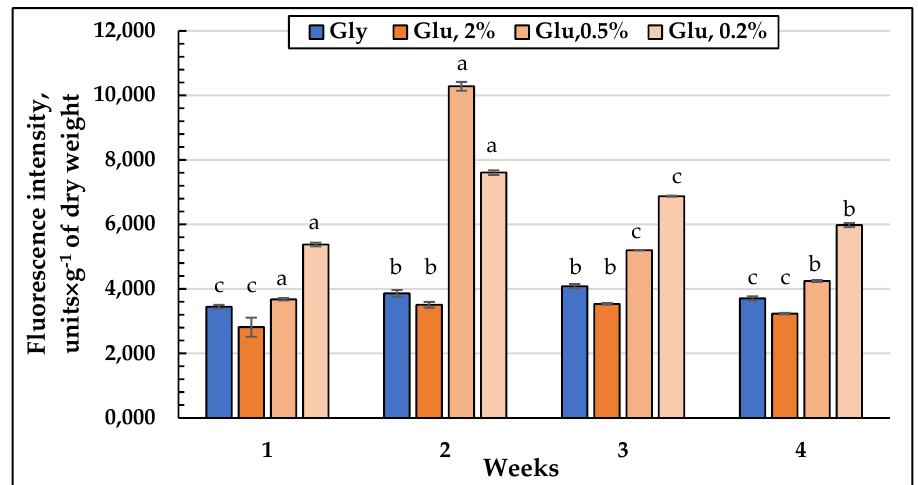
Figure 11. ROS level in the glycerol and glucose assimilating E. magnusii yeast, raised at different growth stages. The dynamics of intracellular ROS production was monitored using a spectroscopic fluorescence probe of dihydro-2 ′ ,7 ′ -dichlorofluorescein diacetate ester H 2 DCF-DA. Values are mean ±S.E.M from 5–6 independent experiments: a–c—0.05 > p > 0.005. The means without letters did not differ significantly.